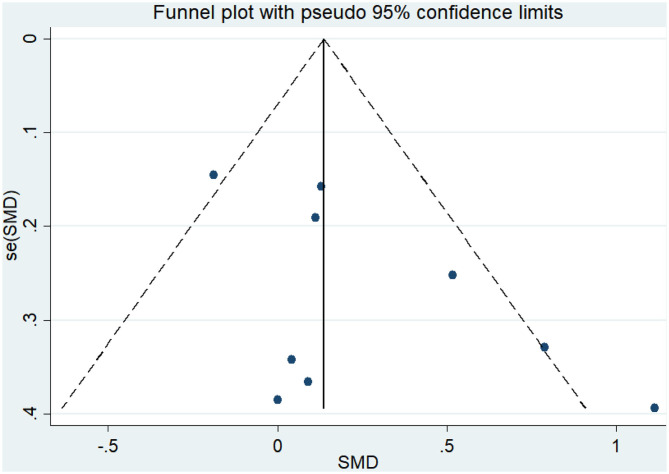
Funnel plot of publication bias for cognitive flexibility.